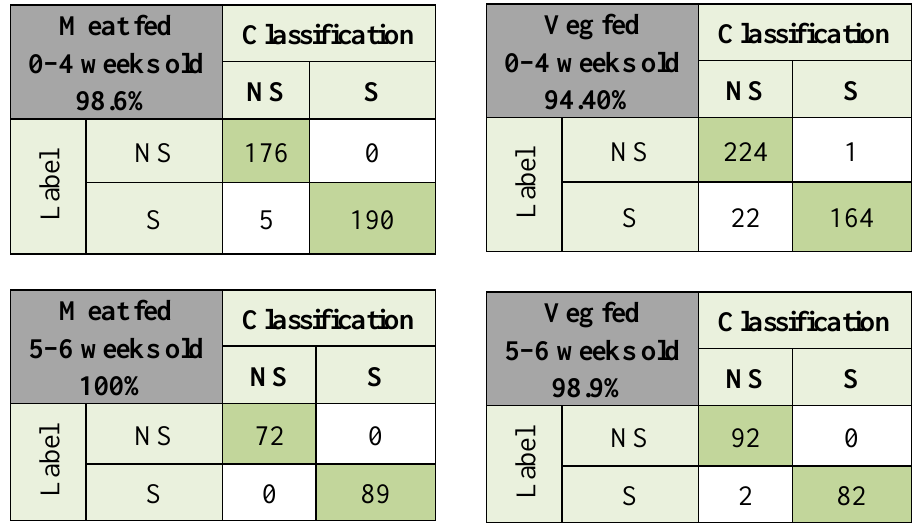
Table 8. Stress (S) vs. Nonstress (NS) classification as a function of age and diet conditions.